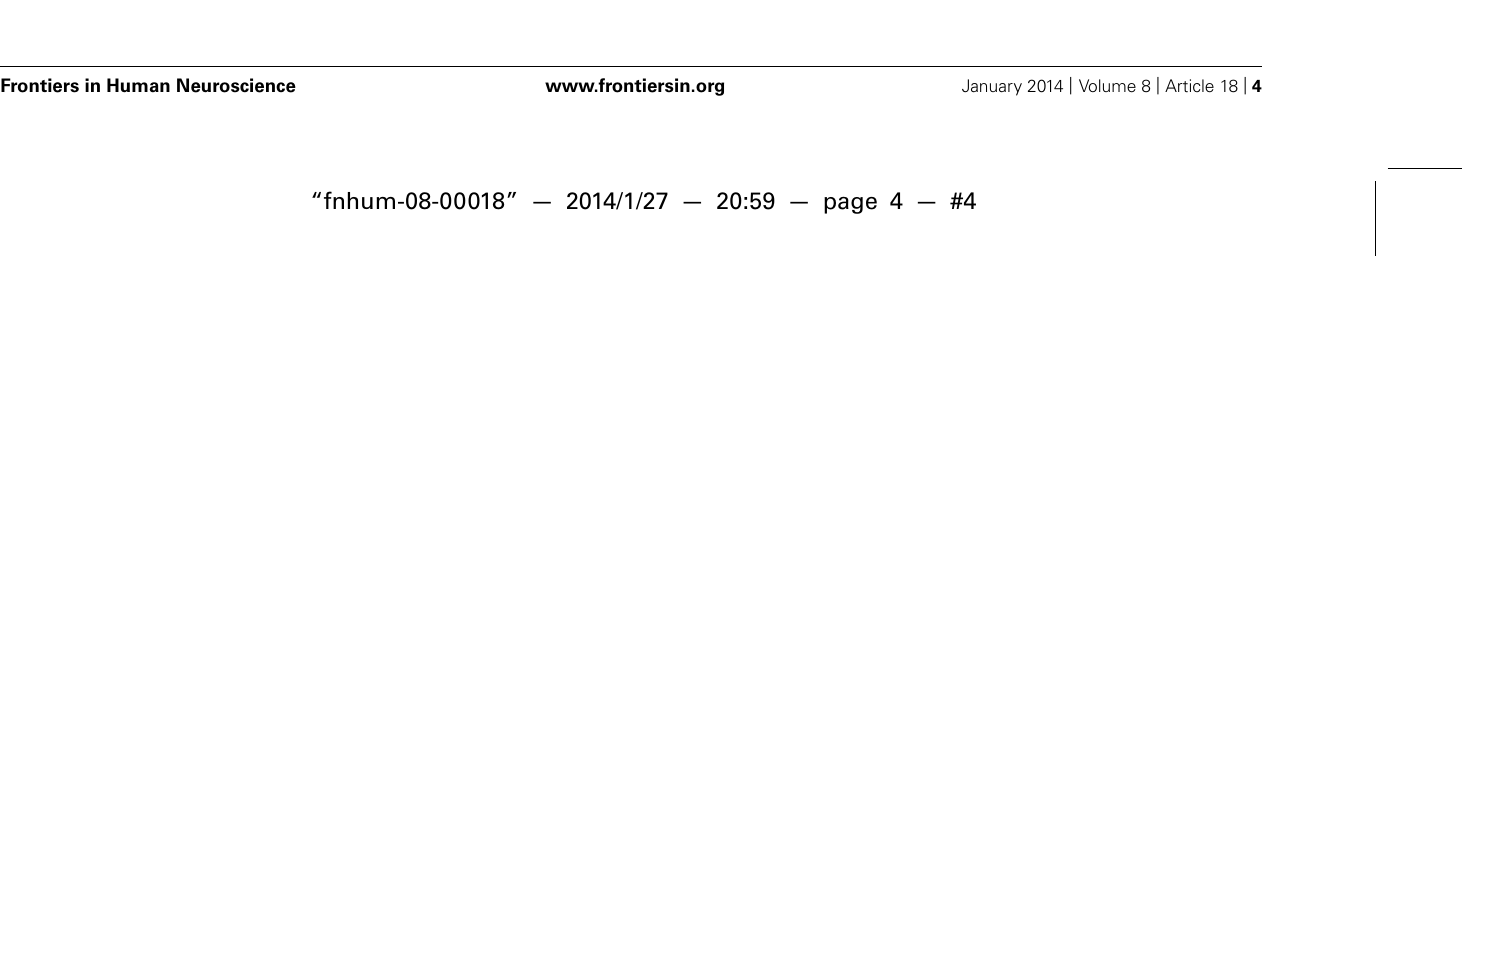
FIGURE 2 | Locations of sources and detectors on the scalp of a representative participant. Light sources are indicated by a red dot and detectors are indicated by an orange dot. Green marks denote fiducial points (nasion and preauricular